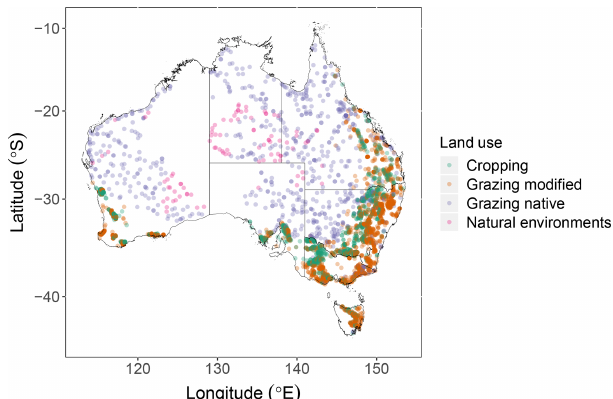
Figure 2. Location of 4431 sites across Australia selected for this study. A total of 1261 sites were under cropping, 2269 sites under grazing modified pastures, 807 sites under grazing of native vegeta- tion and 94 sites in natural environments, mostly under minimal use or managed resource protection in semi-arid and arid